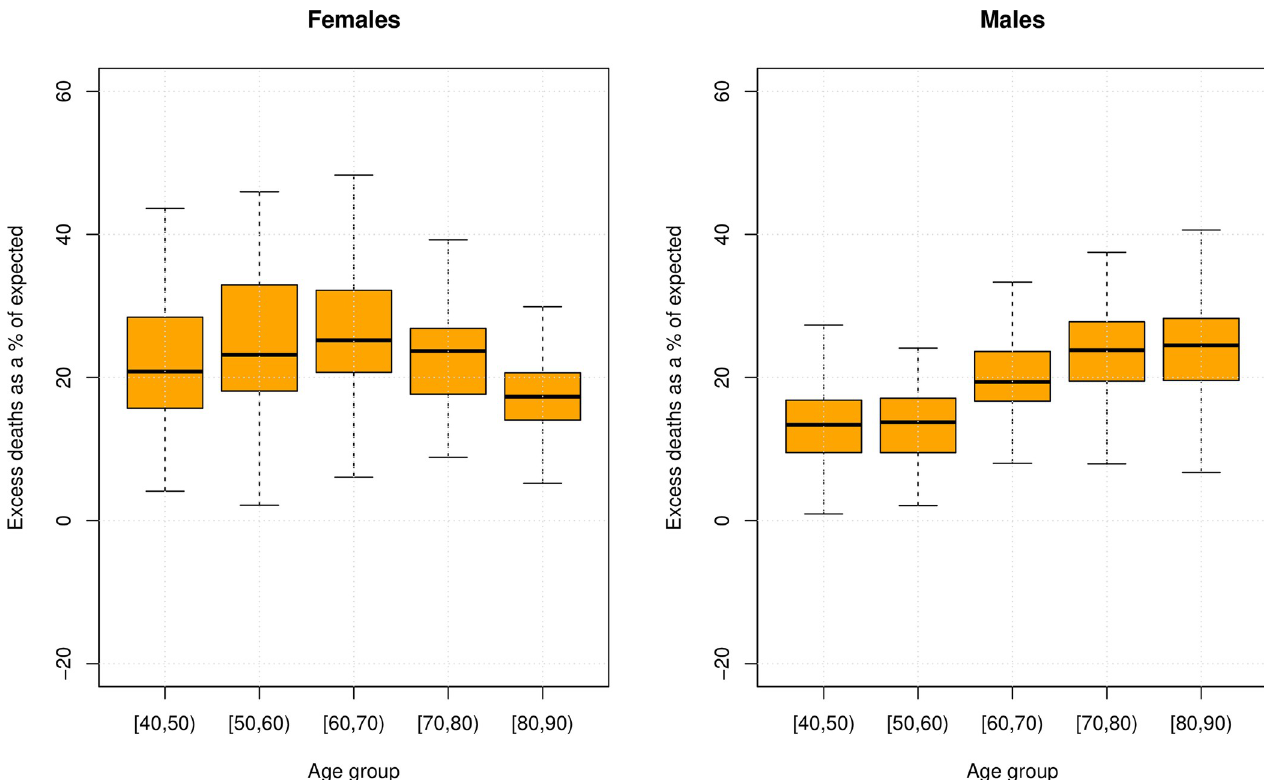
Fig 1. Boxplot of excess mortality of regions (unweighted), males and females, ages 40–90, Russian Federation 2020.